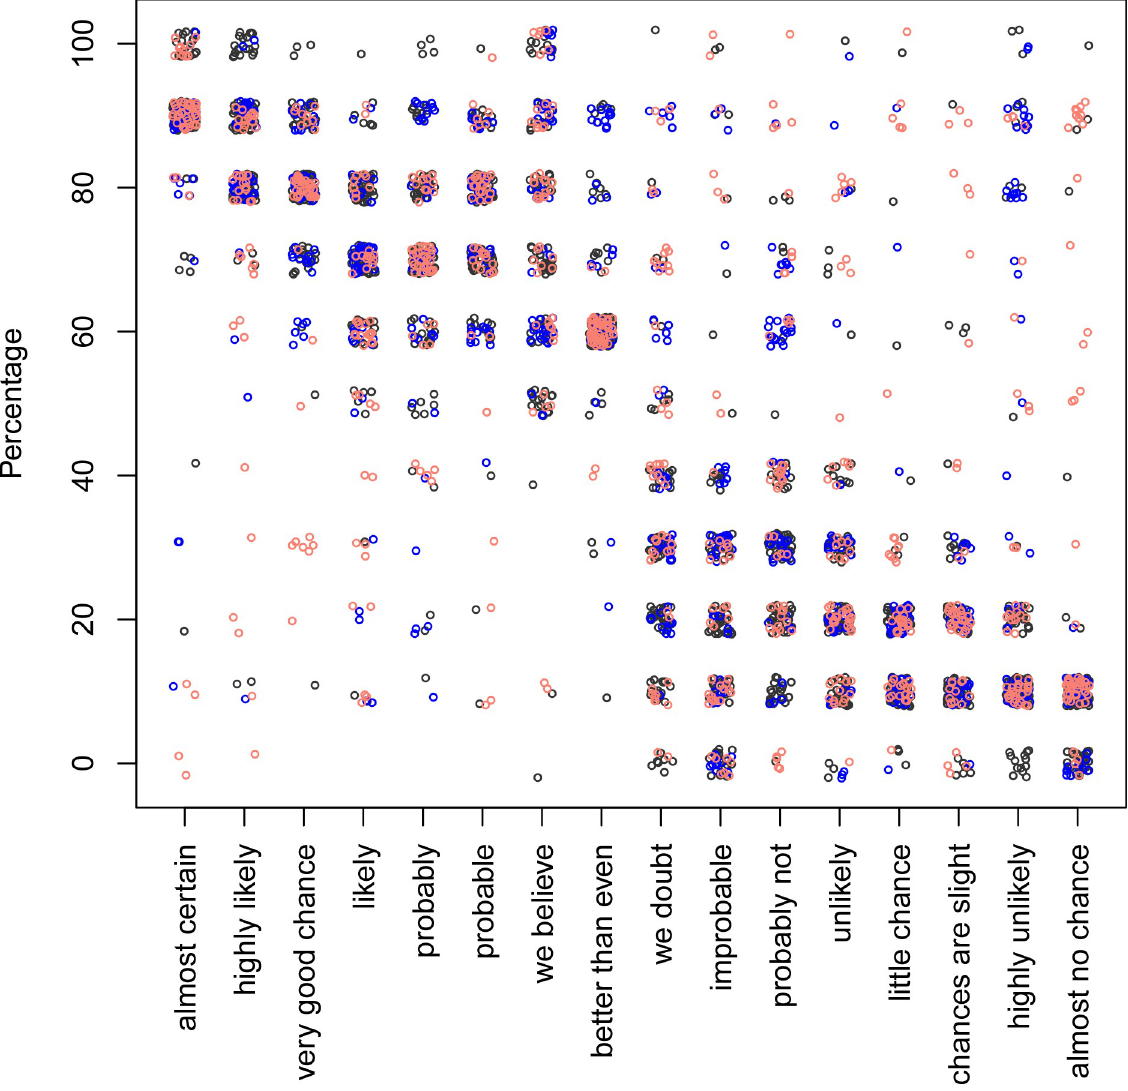
Fig 2. The percentages associated with the phrases, using the “likelihood” prompt. The black, blue, and red colours correspond to the context-free, user and car contexts, respectively. Each dot represents one response.